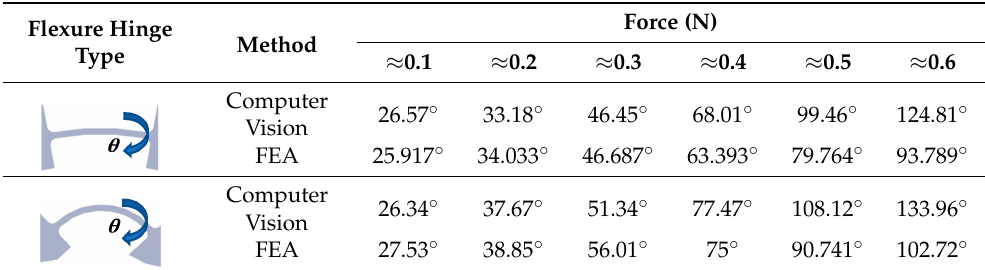
Table 5. New results for the bending angle θ measured at the endpoint of compliant fingers.